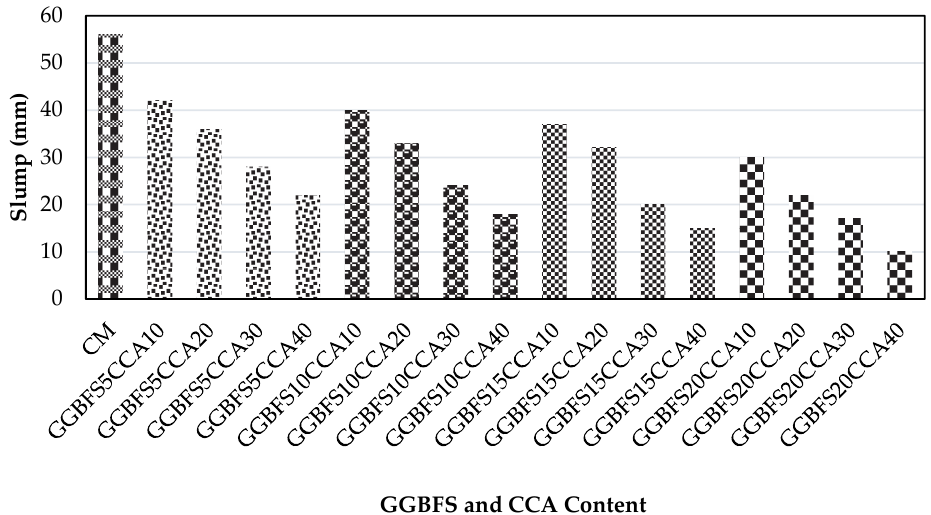
Figure 5. Slump tests of fresh concrete blended with GGBFS along with CCA.